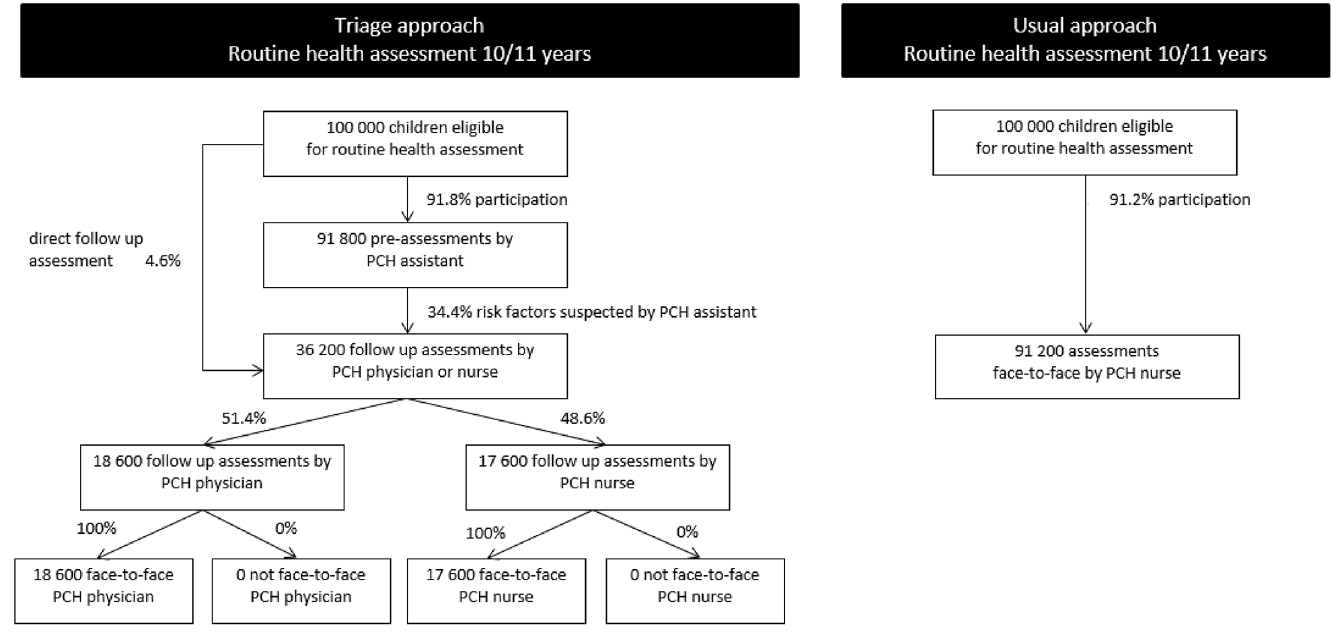
Fig 2. Flow chart outlining the assessments of a theoretical cohort of 100,000children assessedaged 10–11 years, triage and usual approach.